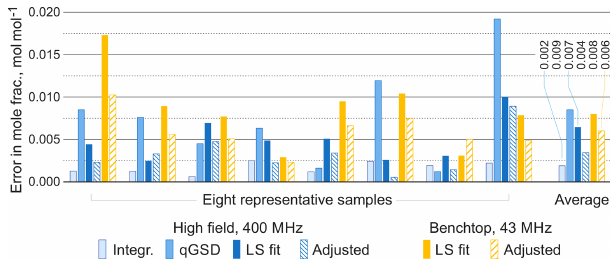
Figure 13. Root mean square errors in estimated mole fractions with respect to gravimetric values in selected representative samples from the set of organic mixtures. The proposed adjustment almost always improves the LS estimates and brings the accuracy of bench- top results to the level comparable with qGSD analysis of high-field data. The average errors are computed over all 22